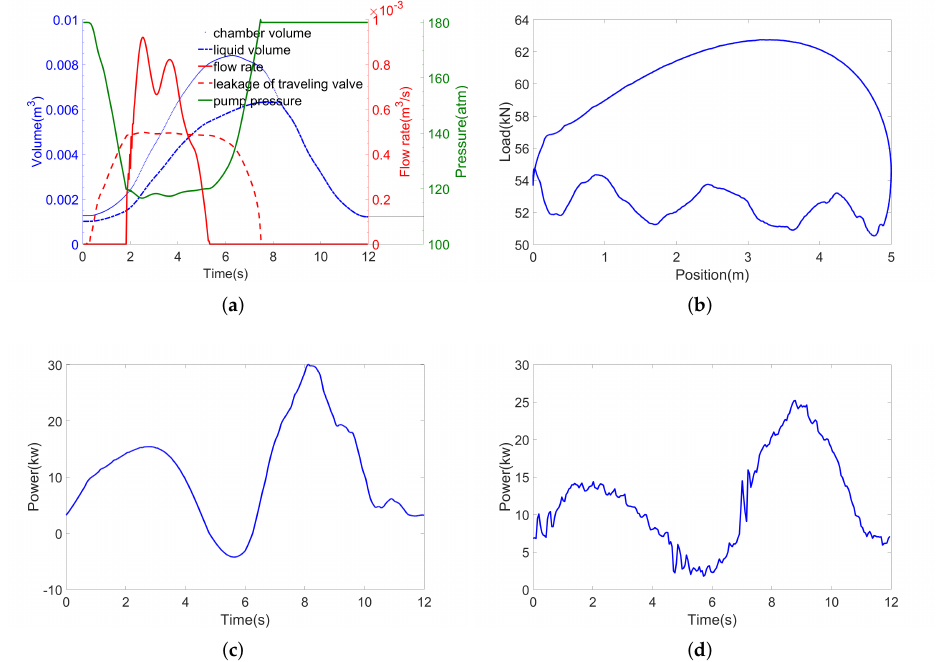
Figure 7. Traveling valve leakage working state. ( a ) Pump simulation. ( b ) Generated DC. ( c ) Generated MPC. ( d ) Actual MPC.